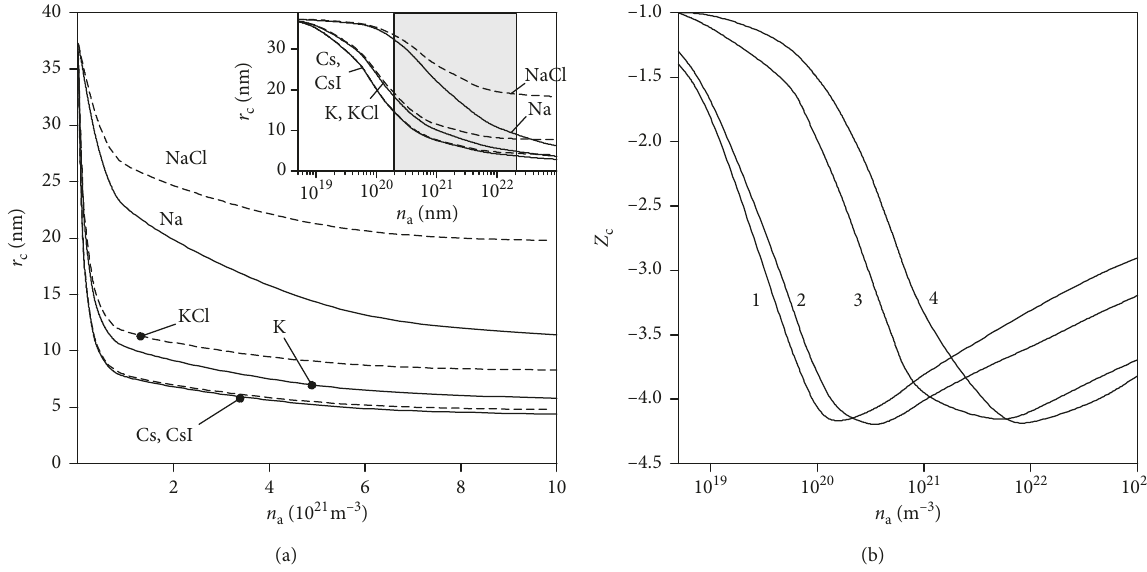
Figure 4: Dependence of the particle radius of Al 2 O 3 (a) and the average particle charge (b) on the concentration of additives’ atoms (1, Cs; 2, K; 3, Na; 4, Li) ( T � 3200K, n Al � 0.5 · 10 22 m − 3 ). Grey area in (a) covers the concentration range that was experimentally studied in [19].